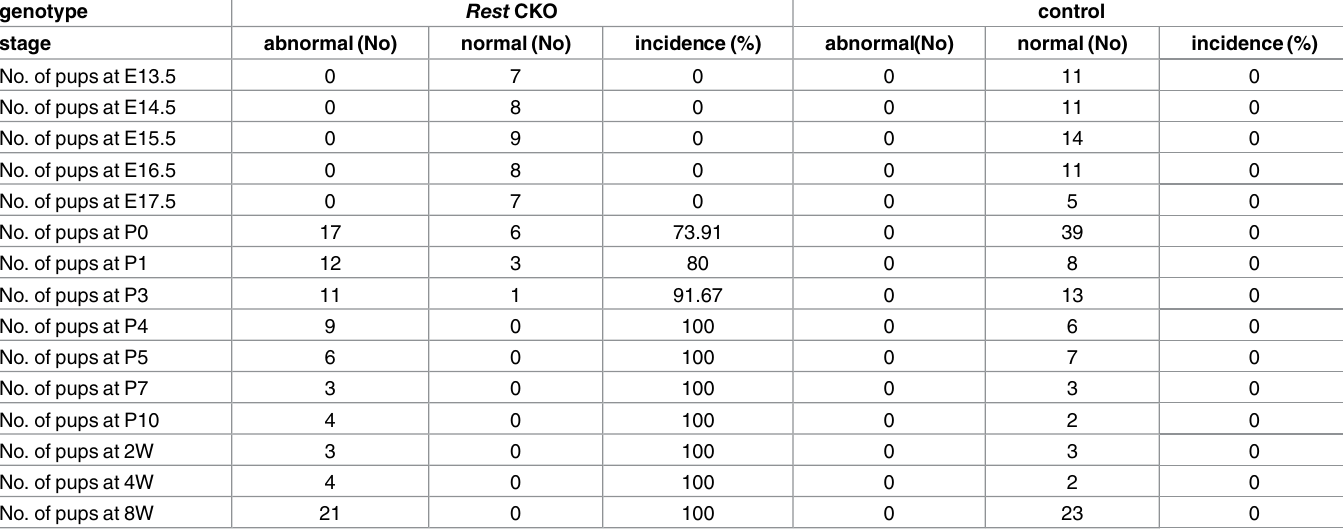
Table 1. The penetrantof the lens phenotypein Rest CKO